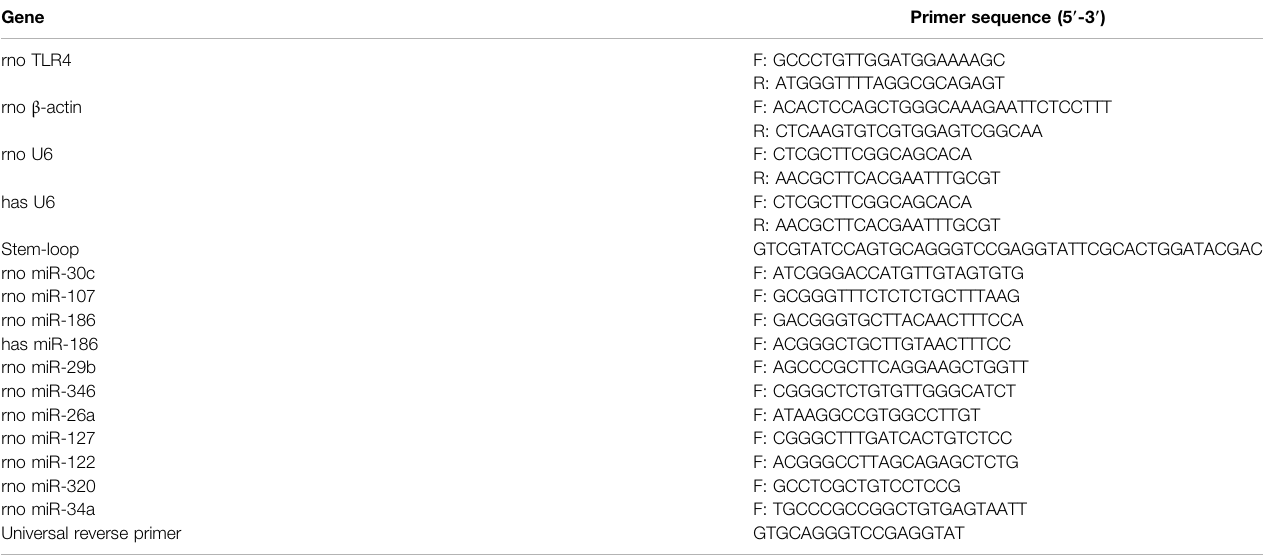
TABLE 2 | Primer sequences of RT-qPCR.